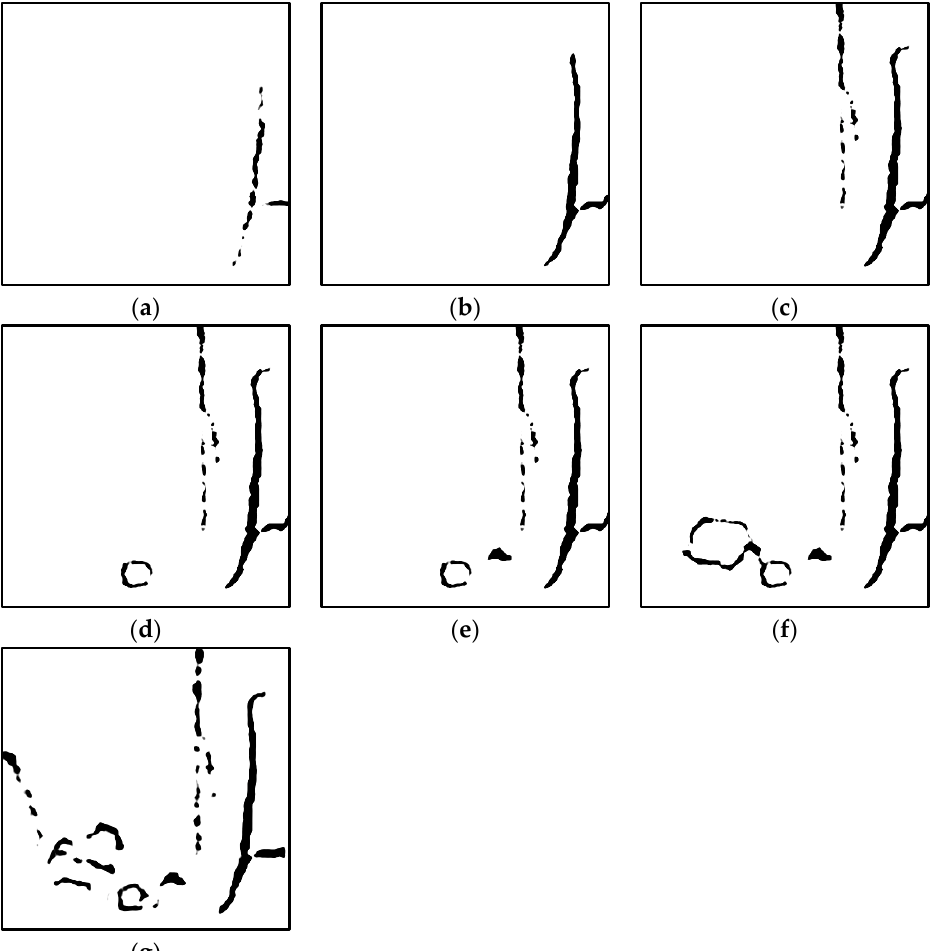
Figure 13. Static images of cracks during the shale destruction process. ( a ) Crack initiation stage; ( b – d ) crack propagation stage; ( e – f ) crack penetration stage; ( g ) overall failure stage. Table 4. Stress and strain values corresponding to the static crack images. Strain Corresponding to Stress Corresponding to the Crack No. Time (S) the Static Crack Image (%) Static Crack Image (MPa)